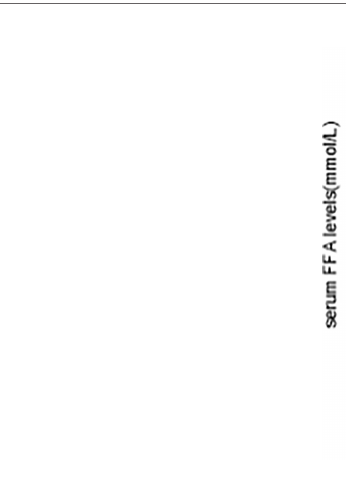
FIGURE 2 | FFA levels before 1-6 courses of chemotherapy. Serum FFA level was signi fi cantly decreased during 1-6 courses of chemotherapy (compared with 1 course, all other courses P <